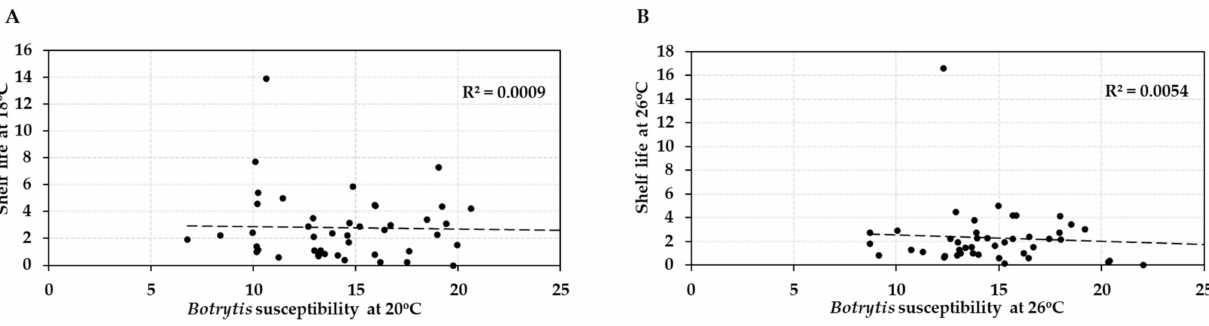
Figure 5. Interrelationships between post-harvest characteristics of fruit from 41 tomato accessions (HT and HS) at normal ( A ) and elevated temperature ( B ). ( A ) Average shelf lives of the tomato accessions compared to their Botrytis susceptibility at 18 ◦ C/20 ◦ C. ( B ) Average shelf lives compared to Botrytis susceptibility at 26 ◦ C. Shelf life was measured in weeks of storage and Botrytis susceptibility by lesion size (in mm) at 3